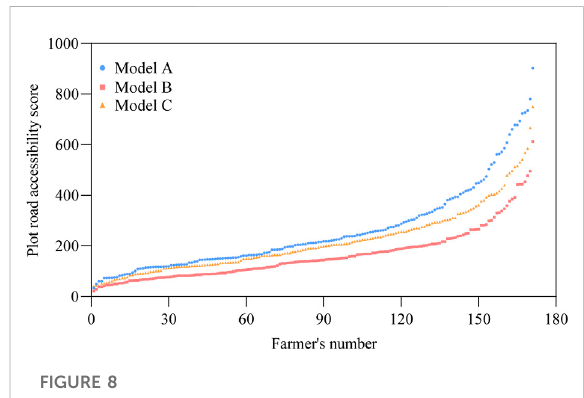
FIGURE 8 Comparison of the values of the three plot road accessibility indices.